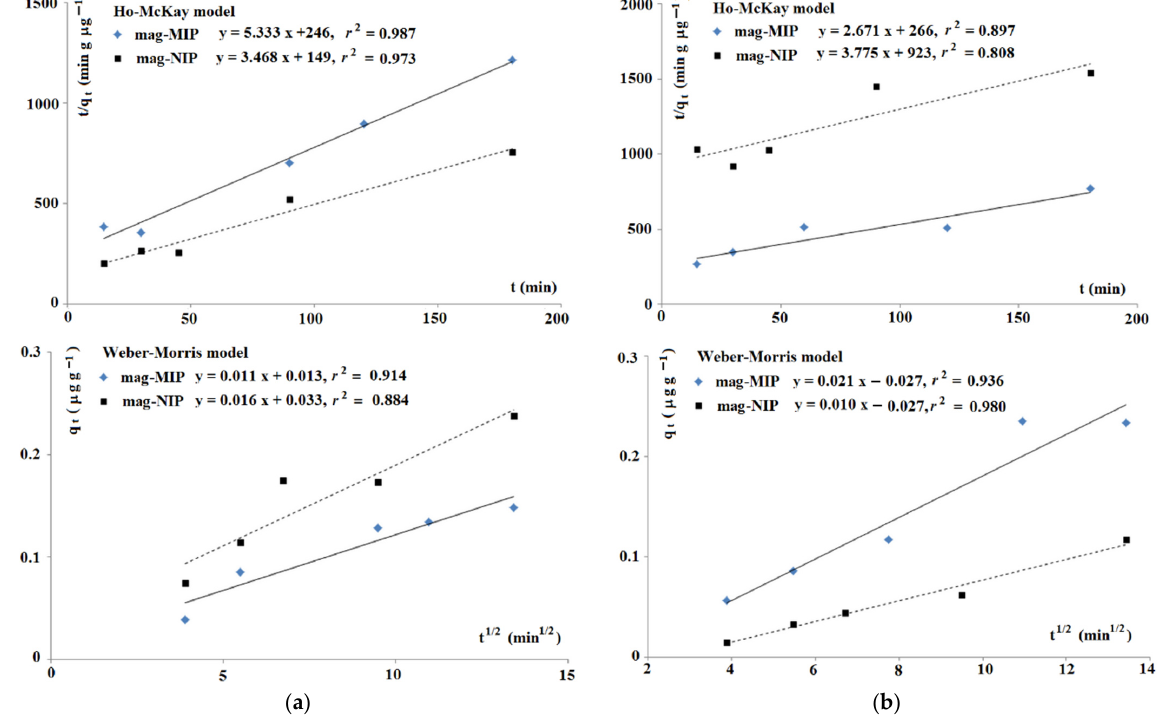
Figure 3. Kinetics data on mag-MIP and mag-NIP for ANT ( a ) and ANT-OH ( b ).